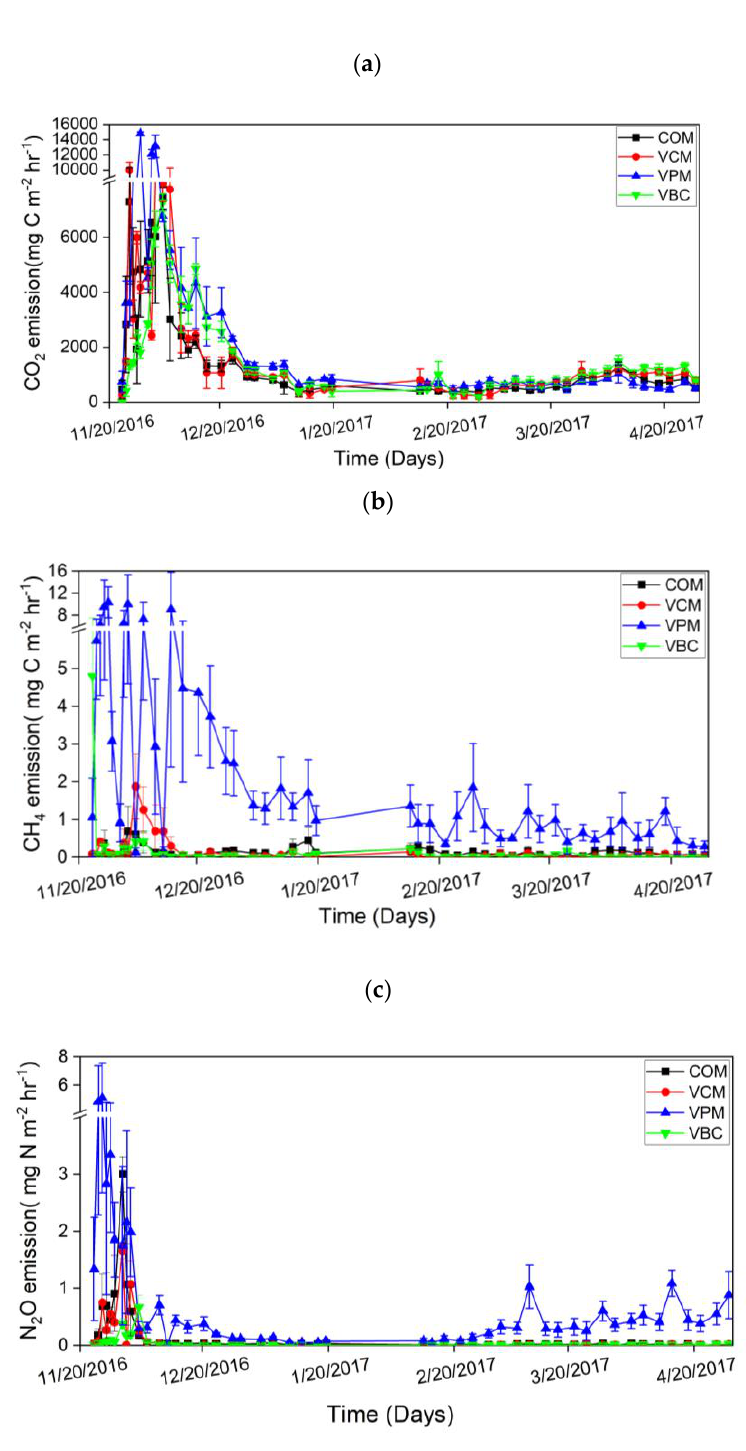
Figure 6. Carbon dioxide emission ( a ), methane emission ( b ), nitrous oxide emission ( c ), during experimental duration. Error bars represent standard errors ( n = 3).